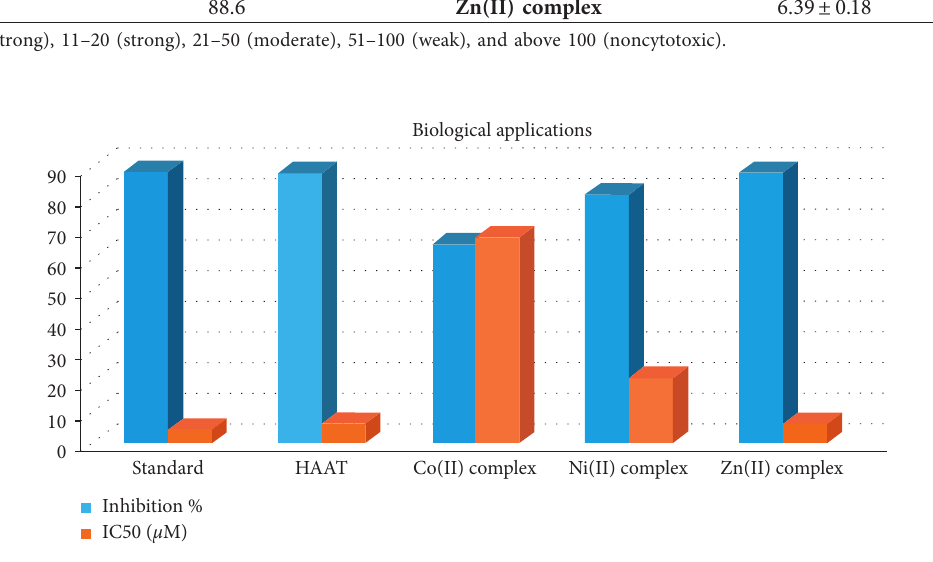
Figure 11: Antioxidant (Inhibition %) and antitumor (IC50) activities of HAAT and its complexes.